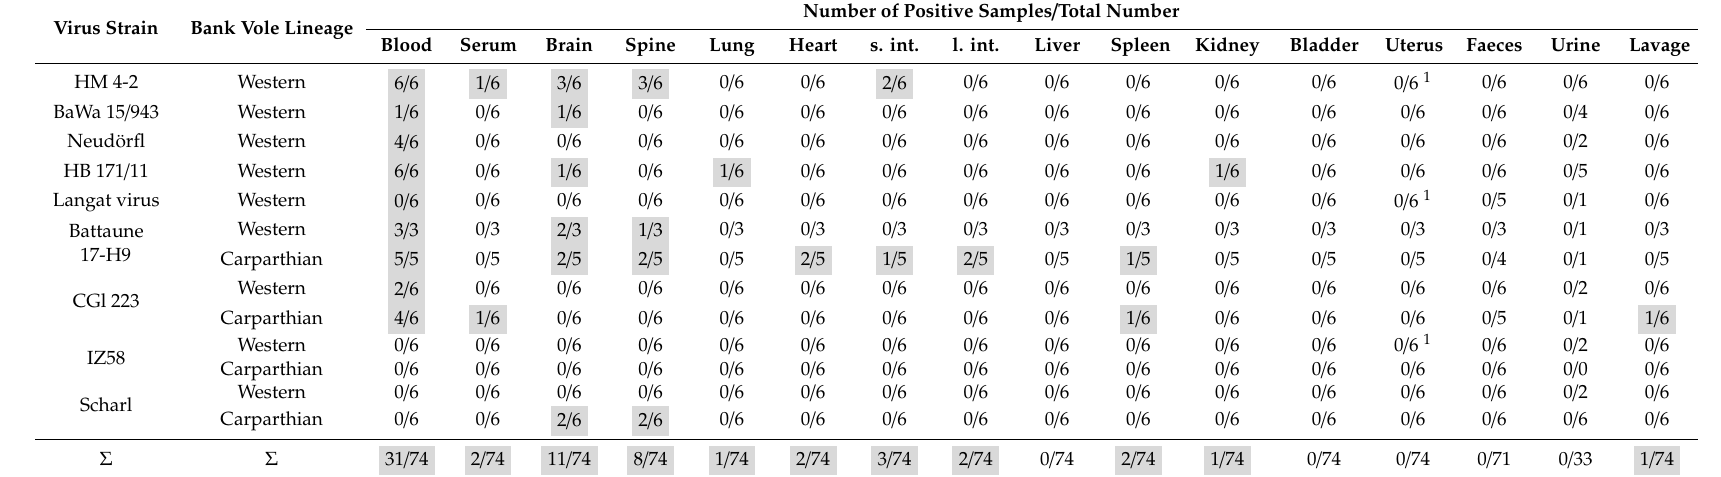
Table 2. Results of RT-PCR testing of all samples taken from inoculated bank voles at 28 days post infection. Groups with at least one positive sample are shaded in grey. S.int. and l. int.: small and large